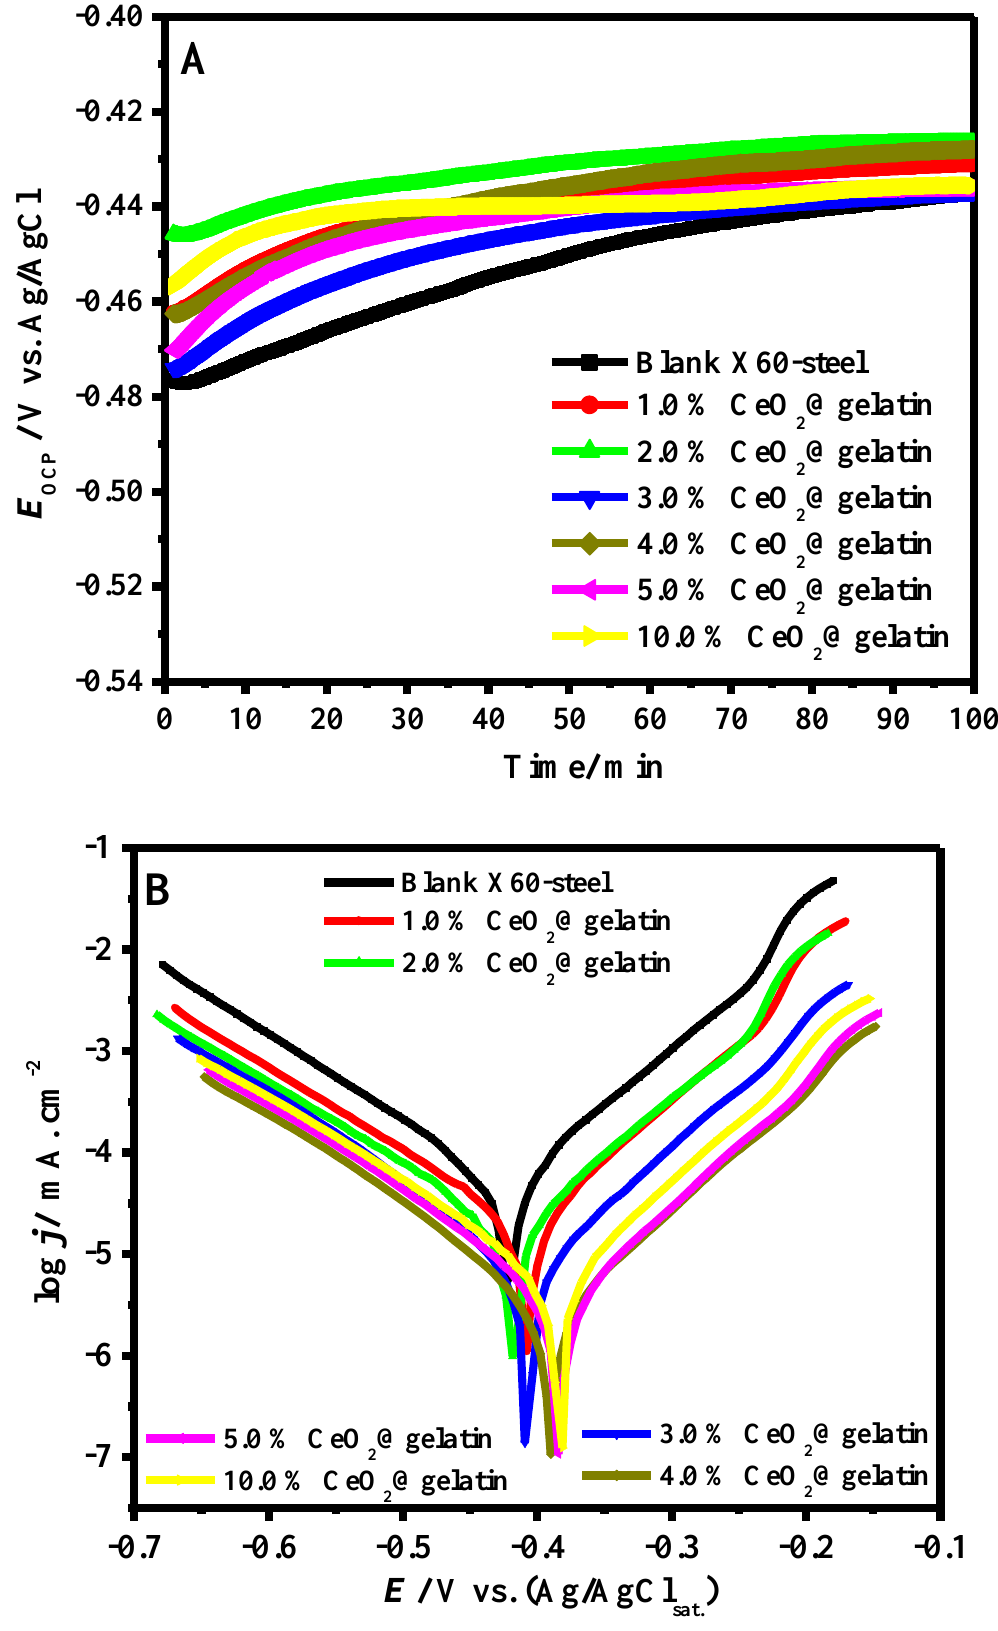
Figure 6. OCP vs. time ( A ) and Tafel plots ( B ) in 15% HCl solution for blank X60 – steel and coated samples with different percent of % CeO 2 @gelatin at 50 °C.